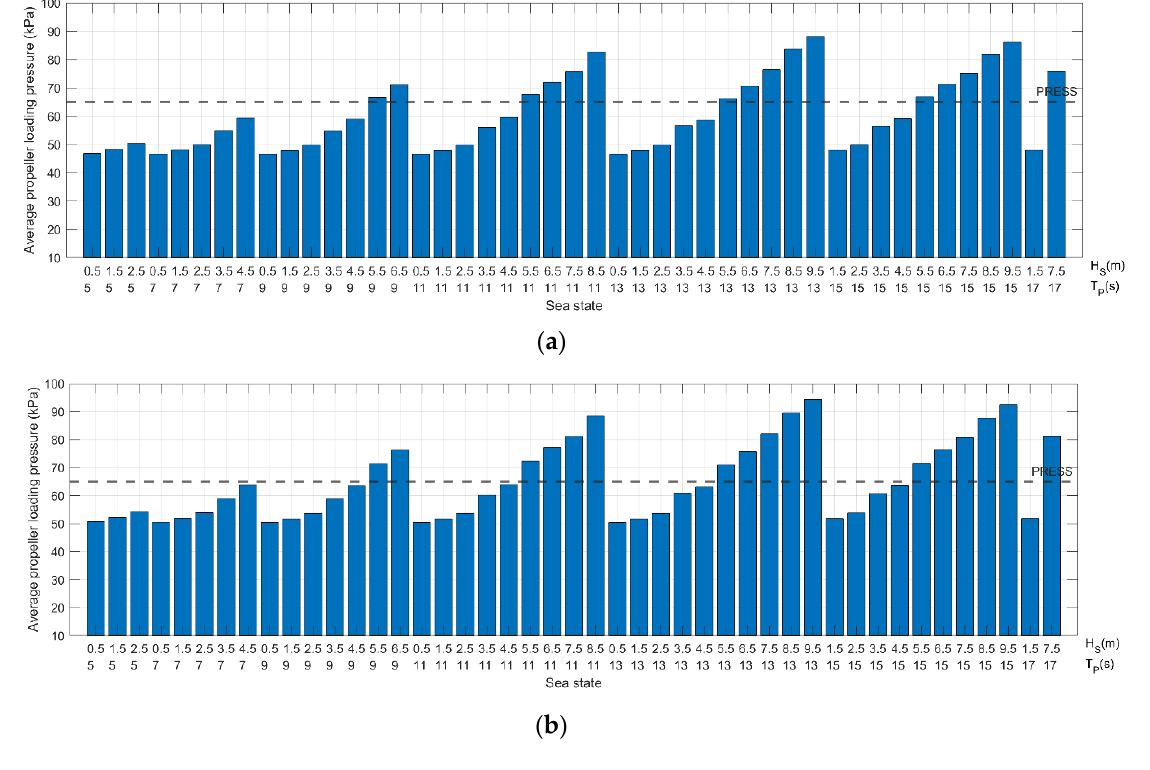
Figure 13. Variation of the average pressure loading pressure for different sea states. Surface roughness: ( a ) 0.15 mm; ( b ) 0.55 mm.